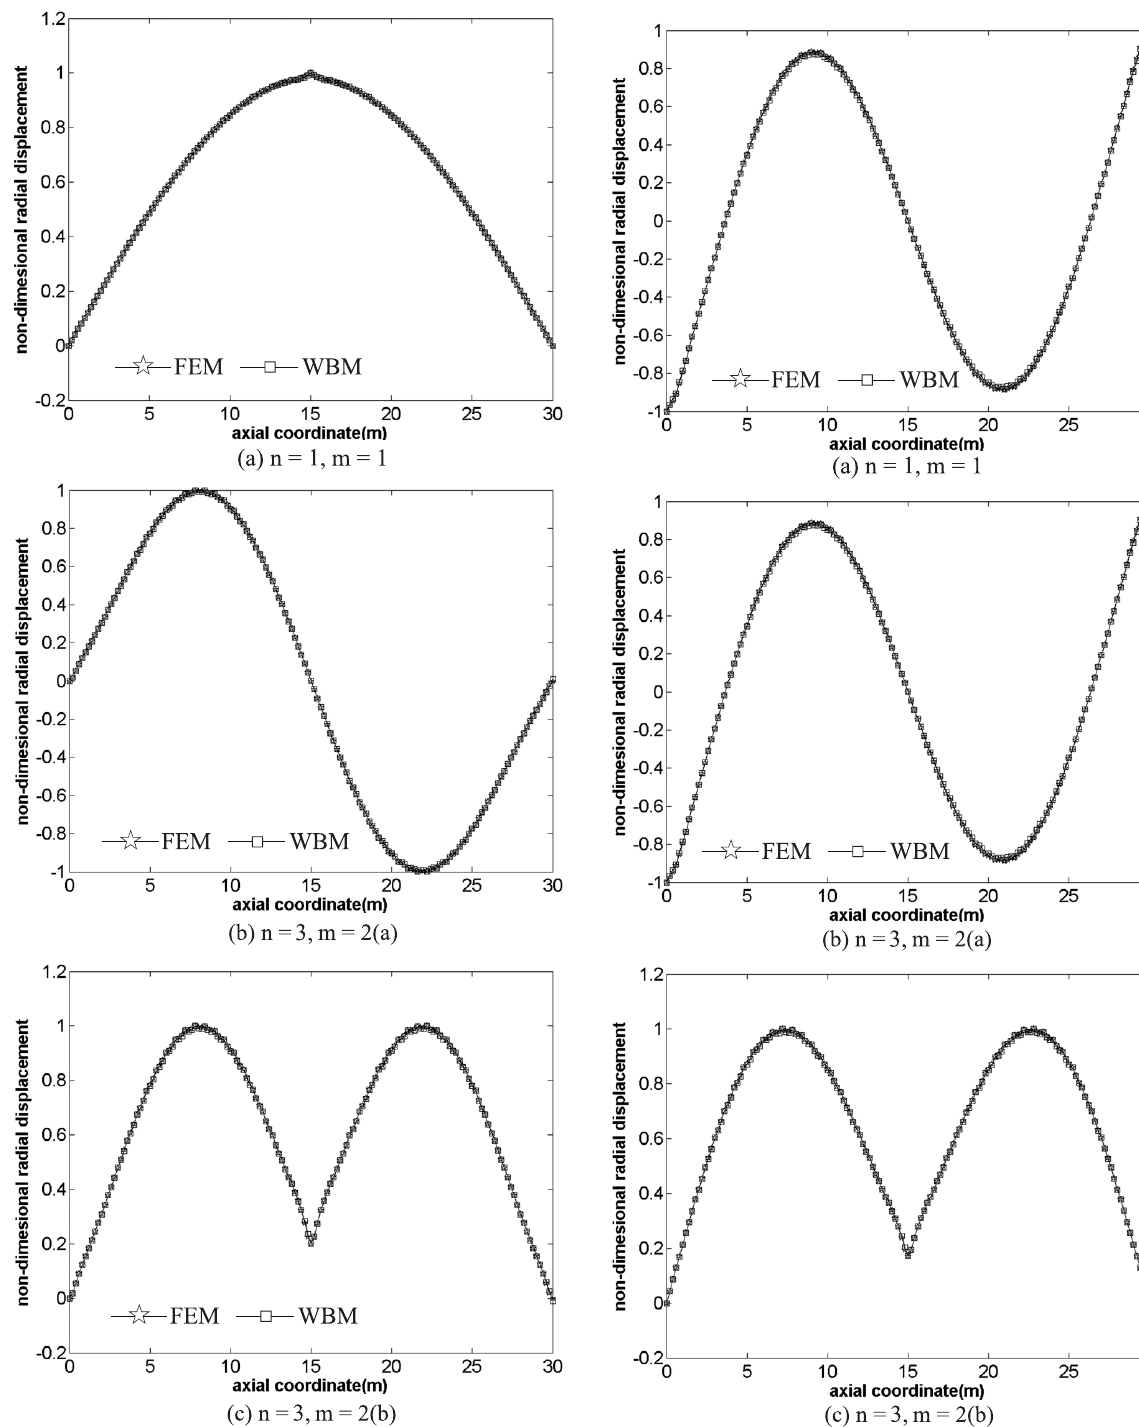
Fig. 11. Comparison of vibration mode shapes of model M2 calcu- lated by FEM and WBM for SD-SD boundary condition.